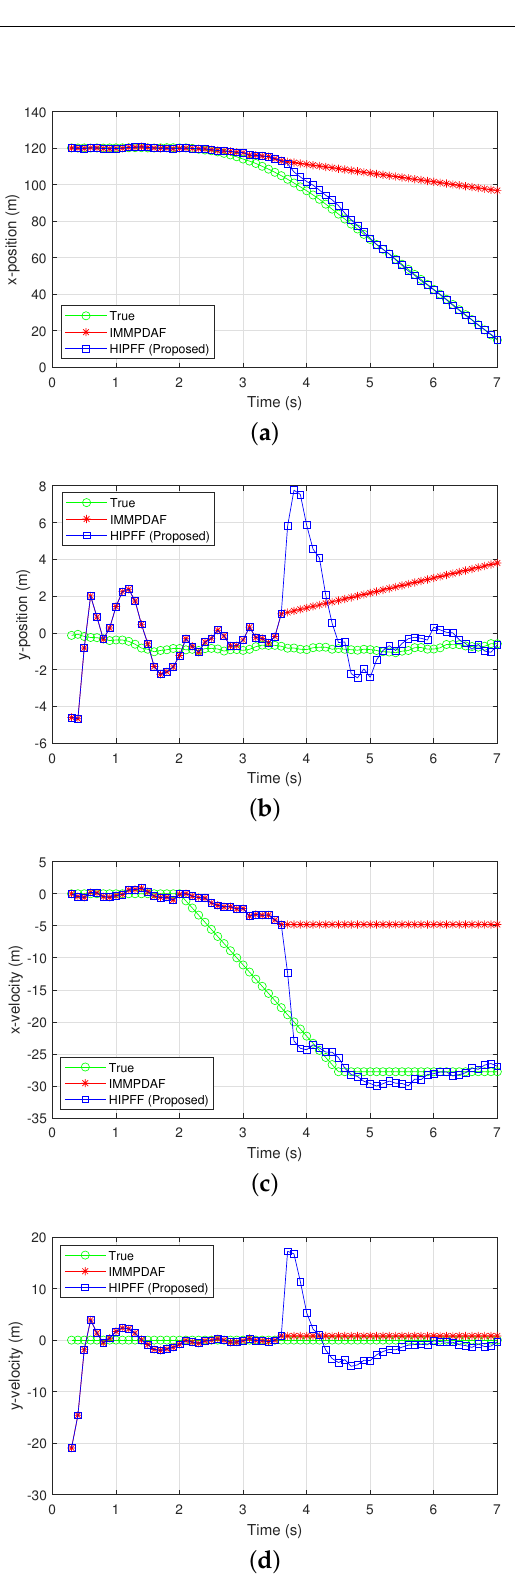
Figure 5. Estimation results of a successful track case: ( a ) x-position; ( b ) y-position; ( c ) x-velocity; and ( d )